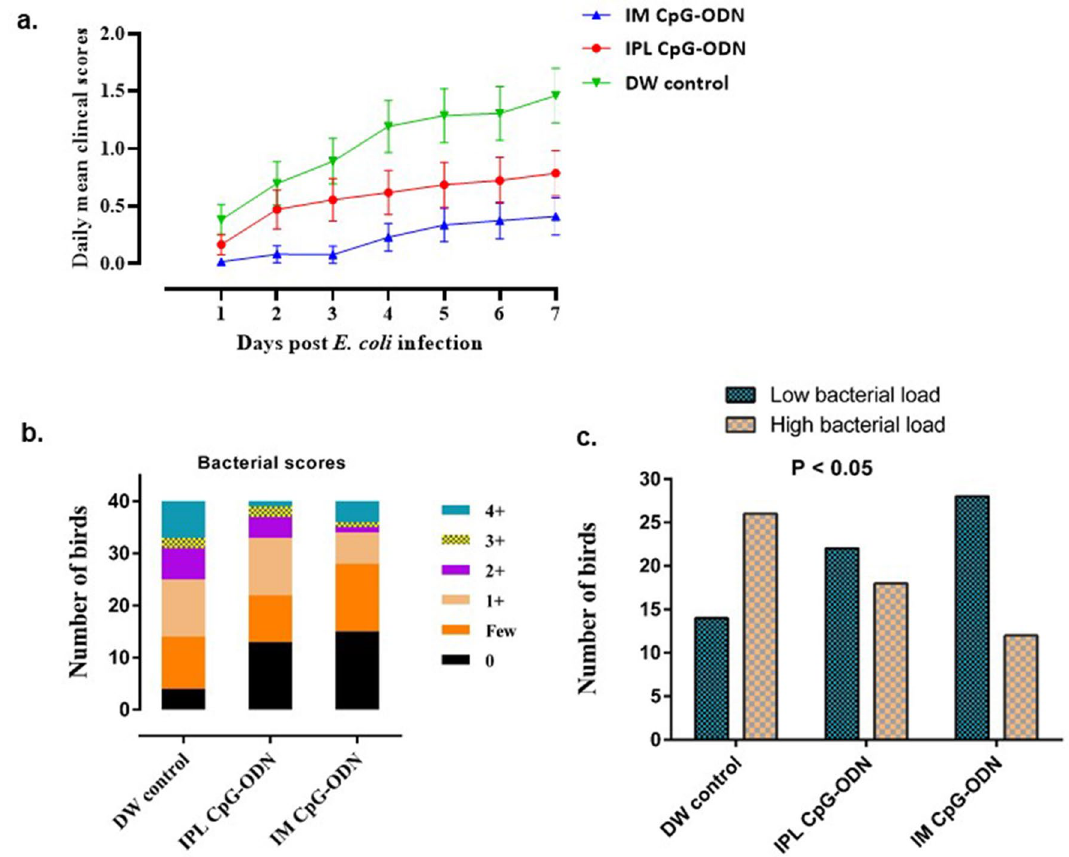
Figure 2. Cumulative clinical scores and air sacs bacterial loads in neonatal chicks following E. coli challenge. Mean cumulative clinical scores (CCS) of each group ( a ), various scores of bacterial growth isolated ( b ), and birds with low and high bacterial loads ( c ) in neonatal chicks (n = 40/group) following E. coli challenge. ( a ) Each data point in line represents the mean CCS value of individual groups on each day, and vertical lines indicate standard error of the mean. The mean CCS values of the IM CpG-ODN group (blue line) and the IPL CpG-ODN group (red line) were significantly lower compared to the IPL DW control (green line) group ( P < 0.001). ( b ) Bar graph shows bacterial scores (0, few, 1 + , 2 + , 3 + & 4 +) of swabs 2 taken from air sacs of birds and cultured on 5% Columbia sheep blood agar by the quadrant streaking method. Higher the bacterial scores greater are the bacterial loads. Increased bacterial load was observed more frequently in lesions from birds in the DW control than in the CpG-ODN groups. ( c ) For the statistical analysis (chi square test) on the bacterial scores as indicated in Fig. 2b, birds in each group were divided into two categories representing the low bacterial loads (no growth & few colonies) and high bacterial loads (1 + , 2 + , 3 + & 4 +). Bar graph shows the number of birds in each group with low and high bacterial loads. The IM CpG-ODN and IPL CpG-ODN administered groups displayed significantly (x 2 = 9.911, P = 0.007) lower bacterial load compared to the DW control